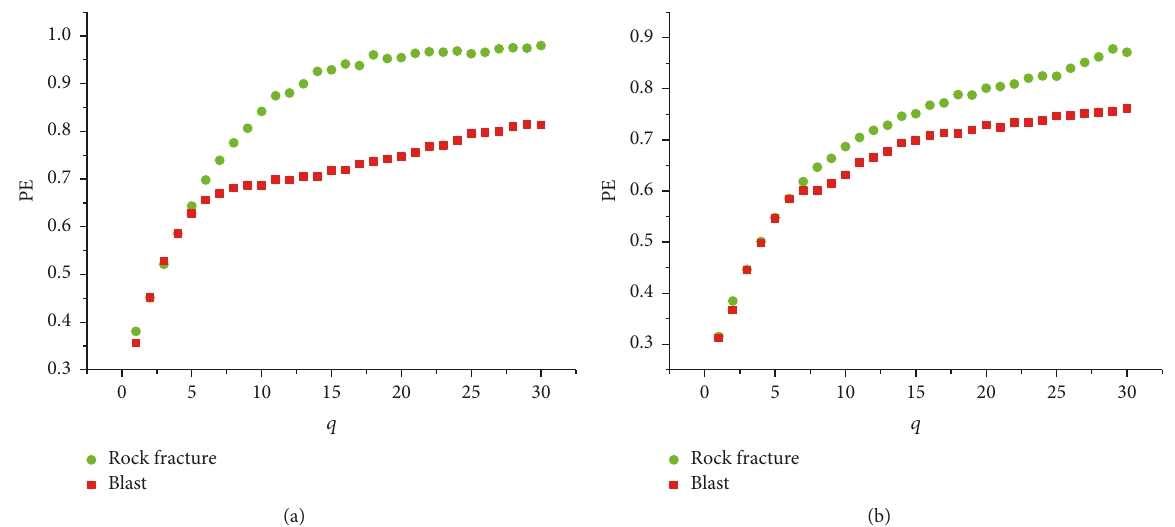
Figure 3: Effect of the scale factors on the PE values. (a) No. 1 sample; (b) No. 2 sample.